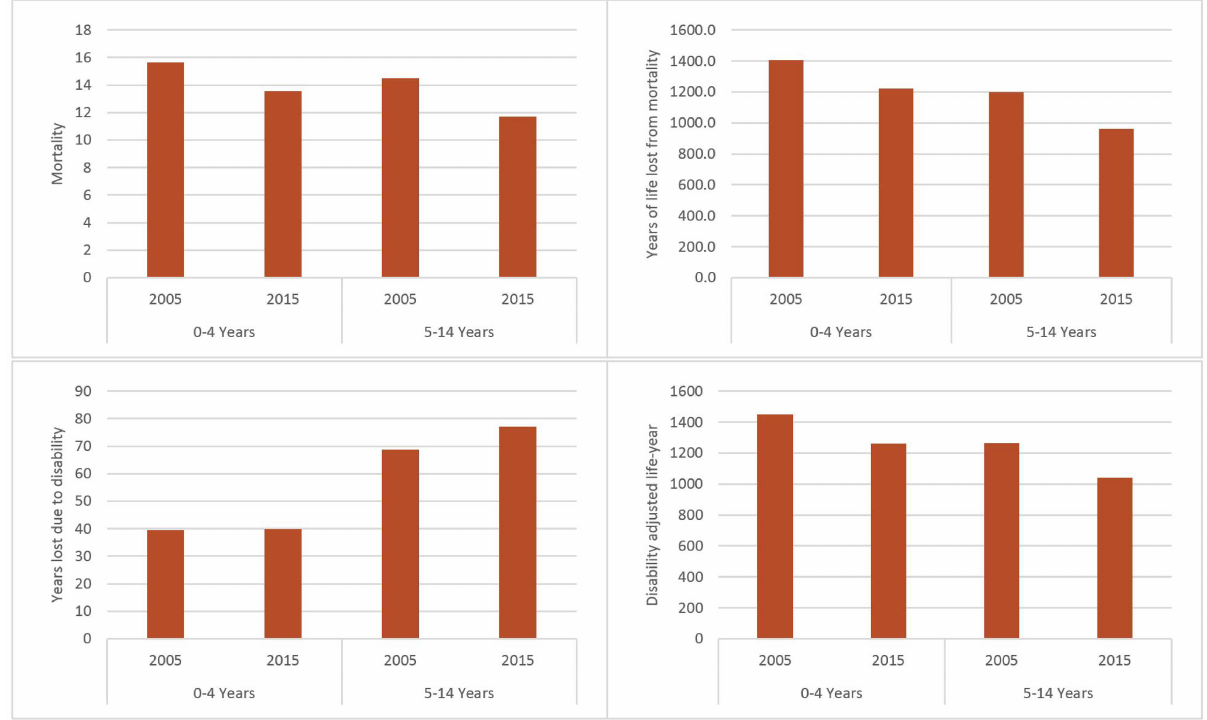
Fig 3. Four measures of health burden of injuries in Ethiopia (thousand), 2005 and 2015. Source: Global Health Estimates 2017.